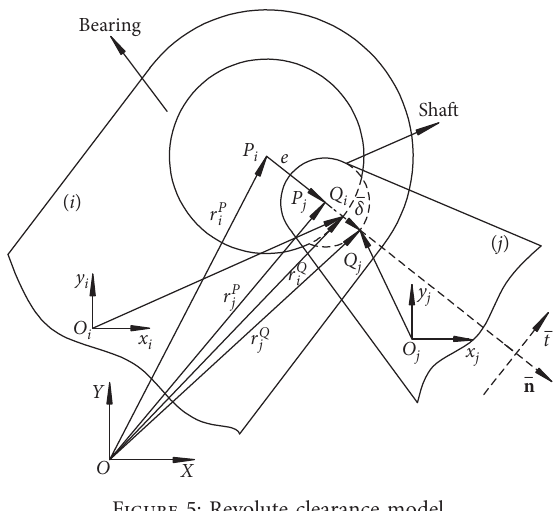
Figure 5: Revolute clearance